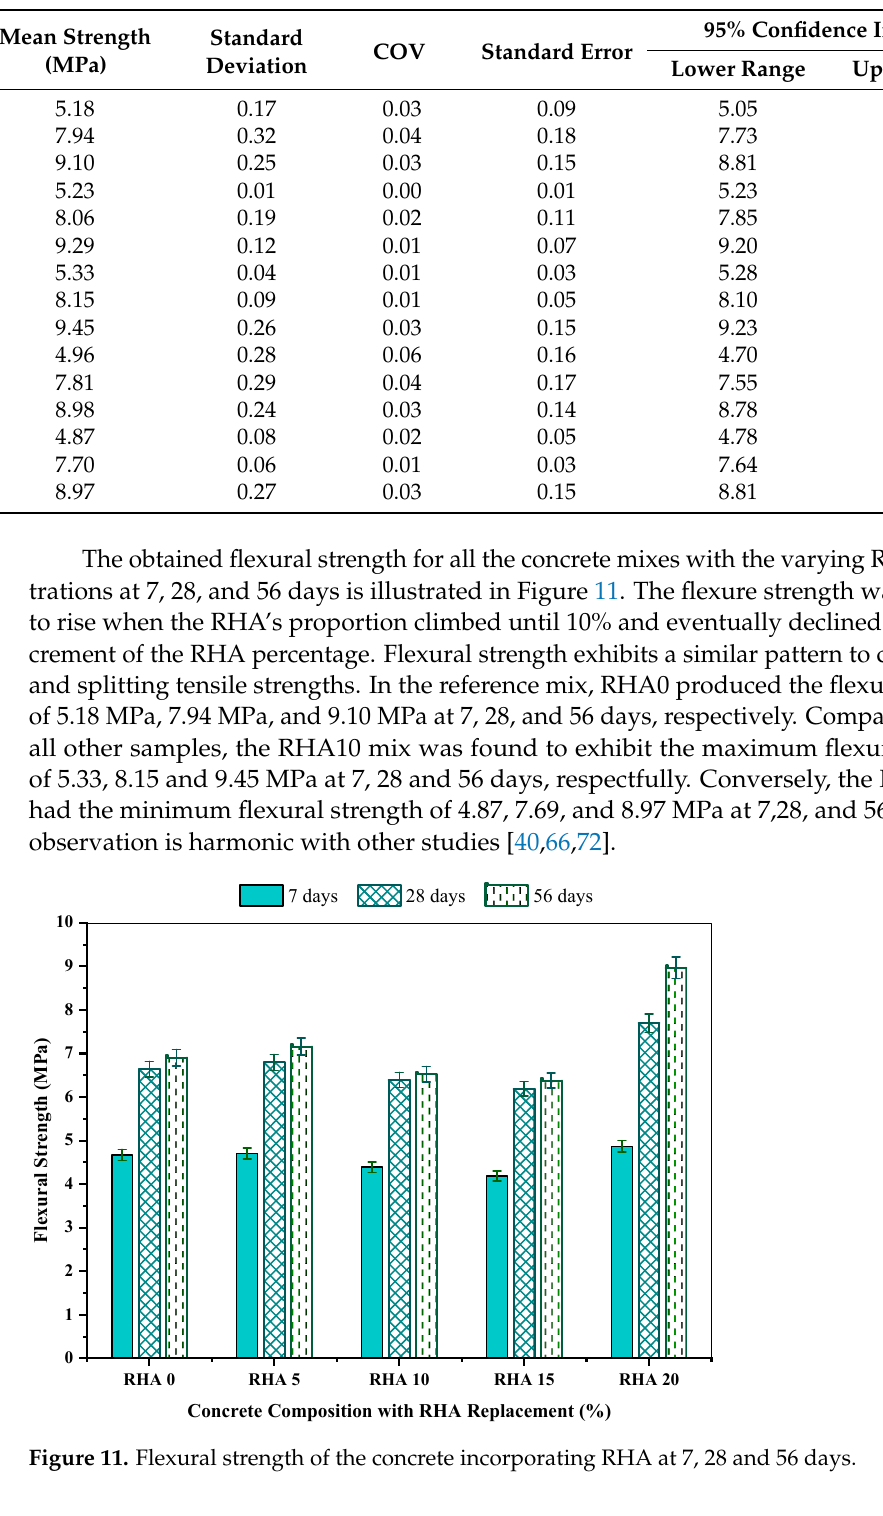
Table 6. Summary of the flexure strength test outcomes.